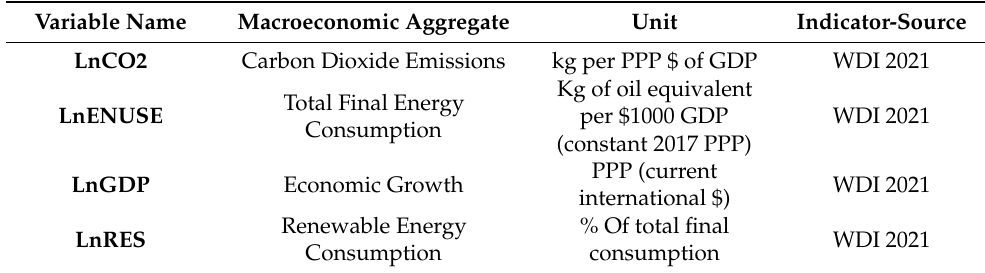
Table 2. Description of